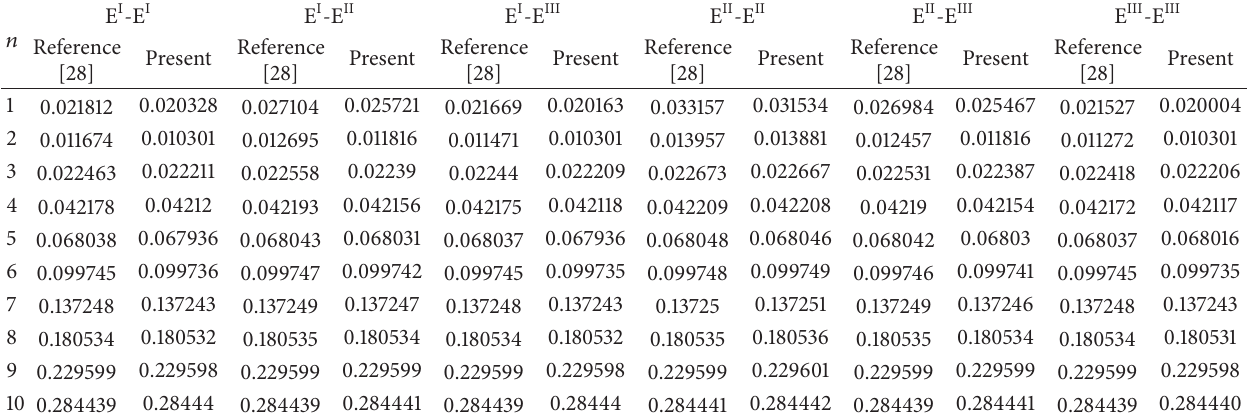
Table 3: Comparison of the frequency parameter Ω = 𝜔𝑅[(1 − 𝜇 2 )𝜌/𝐸] conditions ( 𝑅 = 1m, 𝐿/𝑅 = 20, ℎ/𝑅 = 0.01, 𝑚 = 1).